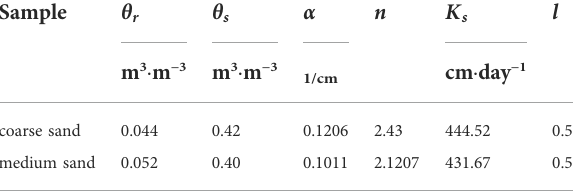
TABLE 3 Hydraulic parameters and dispersion of soil. Sample